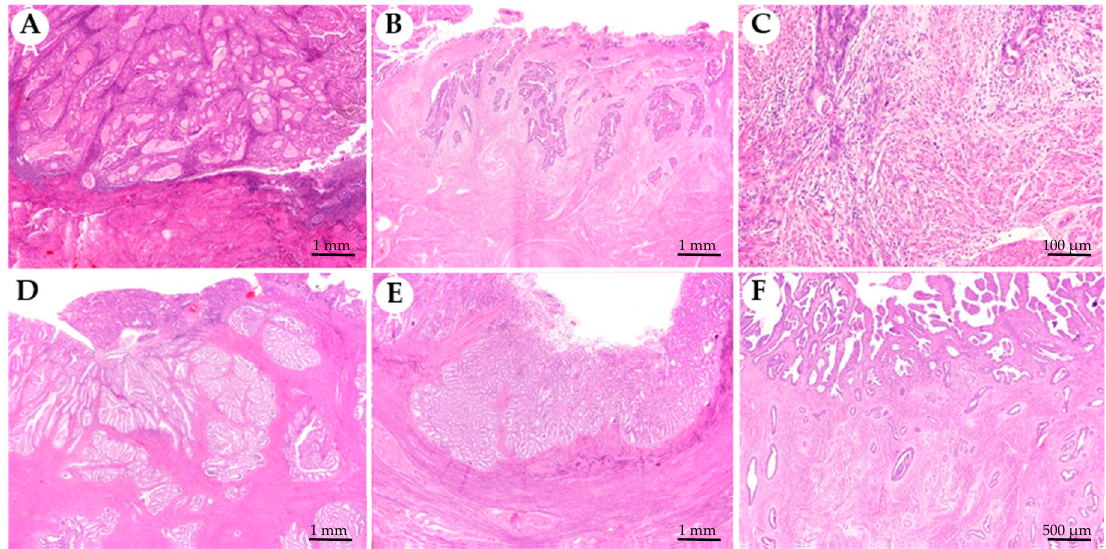
Figure 1. Myoinvasive patterns present in endometrioid endometrial carcinomas. ( A ) Non infiltrative, tumour is confined to the endometrium and does not invade the myometrium. ( B ) Infiltrative glands, composed of single or small groups of glands with irregular contours scattered in the myometrium. ( C ) Microcystic, elongated and fragmented glands (MELF) identified at the leading edge of the tumour associated with neutrophils infiltrate. ( D ) Adenomyosis-like, composed of groups larger than five glands with round borders within myometrium simulating adenomyosis. ( E ) Broad front, which has a linear limit between the tumour and the stroma beneath. ( F ) Adenoma malignum is composed of low cytological grade, regular, rounded, and widely spaced glands .